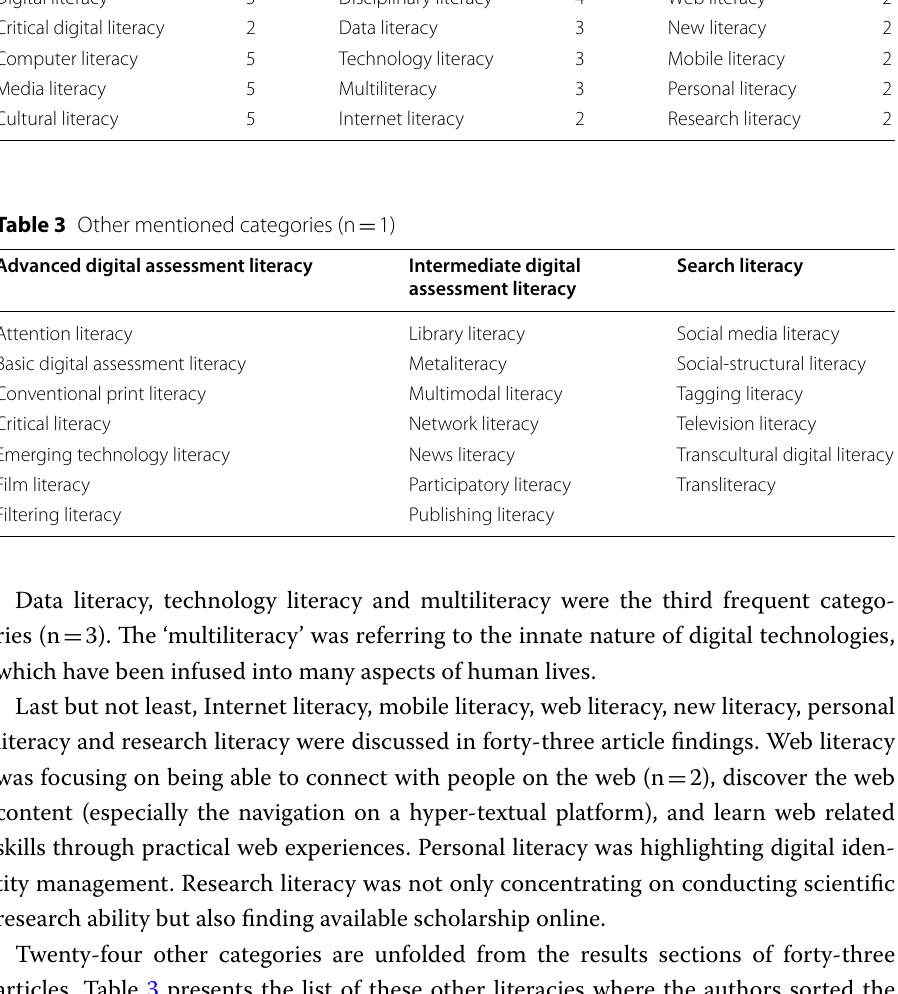
Table 2 Categories (more than one occurrence) under ’literacies’ major theme Category n